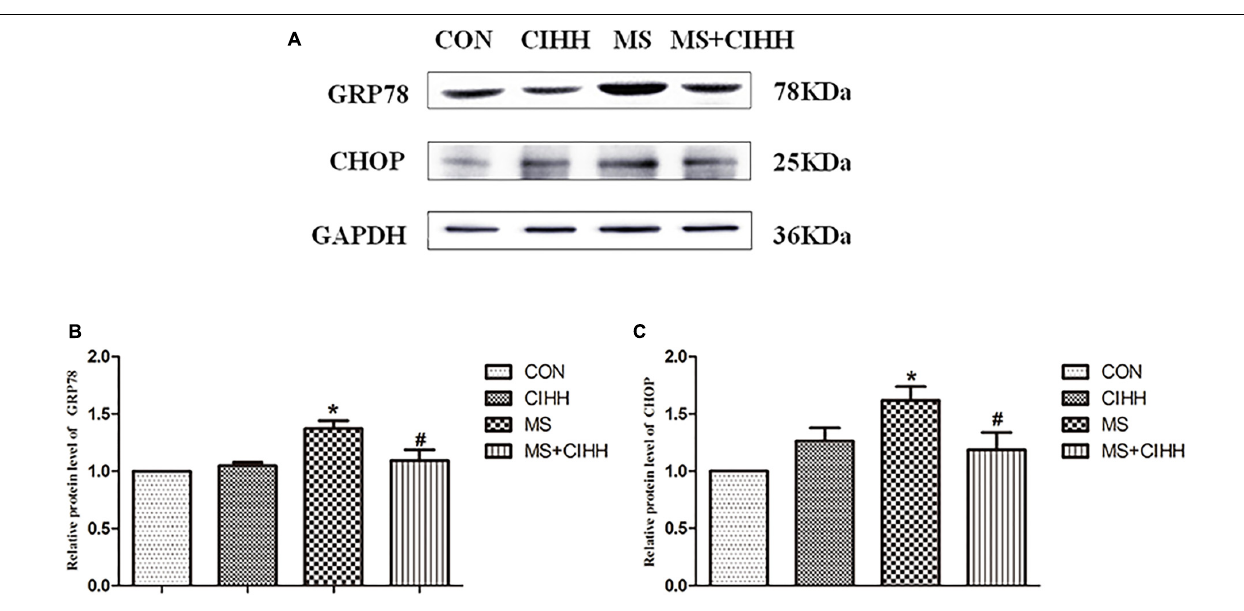
function: improvement or inhibition. Therefore, we further observed the effect of CIHH on one signaling pathway of inducing autophagy – AMPK-mTOR signaling pathway.